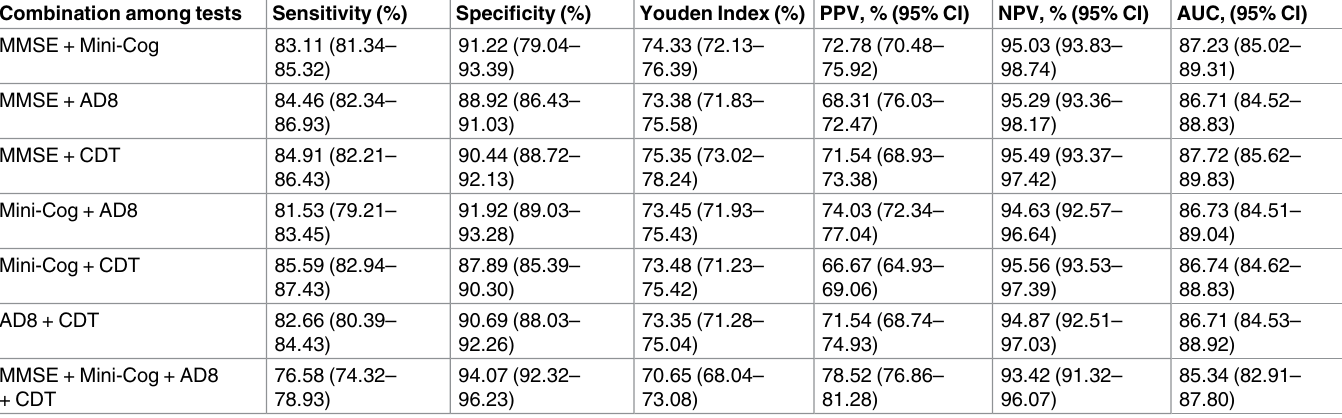
Table 3. Diagnostic test characteristics of the serial mode combinations among screening tools * .